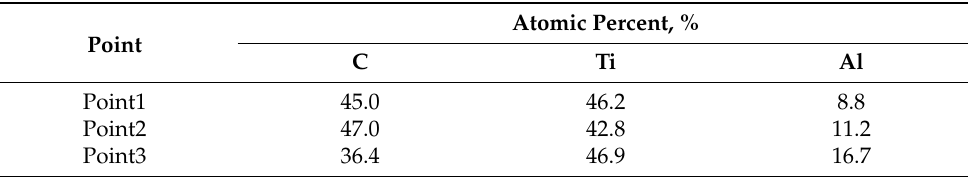
Table 3. Elemental contents for different points obtained by EDS in Figure 5g. Point